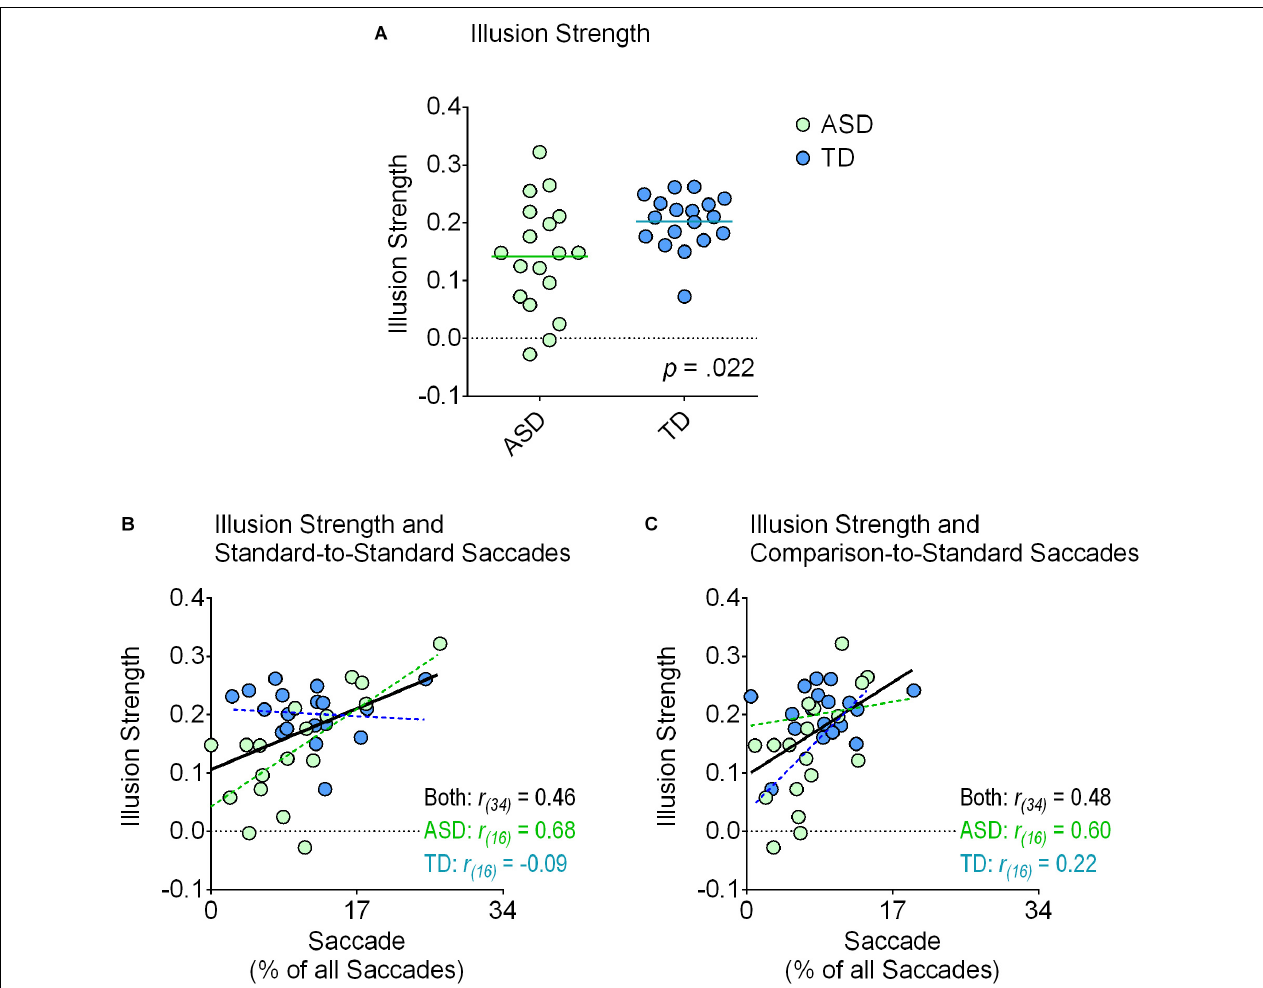
FIGURE 2 | Illusion strength and correlations with saccadic eye movements to the standard stimulus. The top panel (A) displays each individual’s susceptibility index score (green circles, ASD group; blue circles, TD group) for the Shepard illusion. The lines represent the means for each group. As shown in the graph, we found a significant reduction in the ASD relative to the TD group. The other plots demonstrate the strength of the Shepard illusion as a function of the percentage of saccades that were classified as starting from one location to a different location within the standard stimulus (B) and classified as starting from one location on the comparison stimulus to a location on the standard stimulus (C) . In both instances, the overall correlations (in black) were significant after correcting for multiple comparisons using the Bonferroni method ( p < 0.05). Additional linear regression analyses revealed that these correlations were primarily driven by the ASD group. Specifically, in both cases, the slopes between the two groups were different from each other ( p < 0.05), positively correlated in the ASD group ( p < 0.05; in green), and not correlated at all in the TD group ( p ≥ 0.378; in